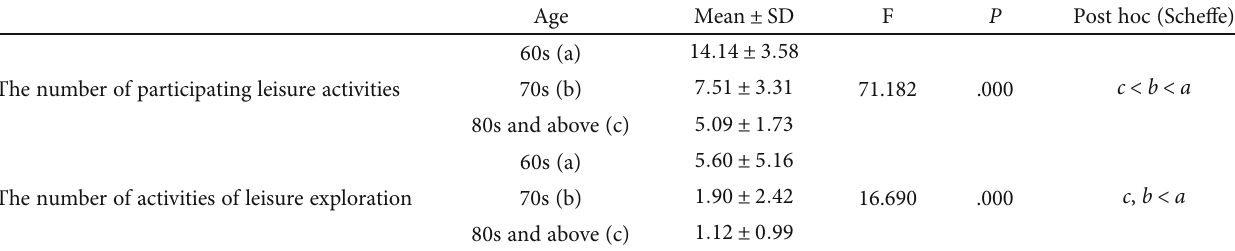
Table 6: The result of discrimination validity ( N = 100